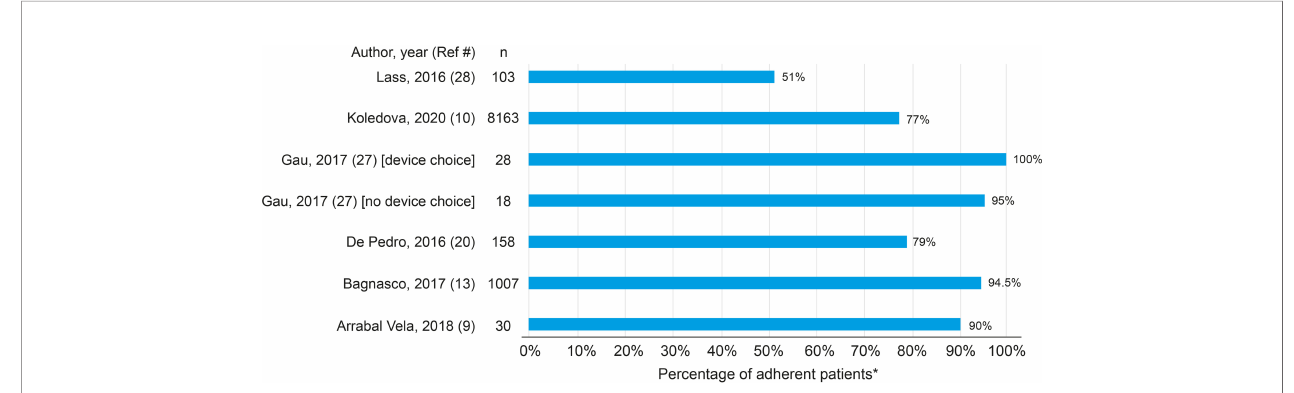
FIGURE 4 | Percentage of patients with adherence > 85%. *Adherence > 85% de fi ned as missed < 1 dose per week, or patients were administered or had in possession > 85% of prescribed doses.